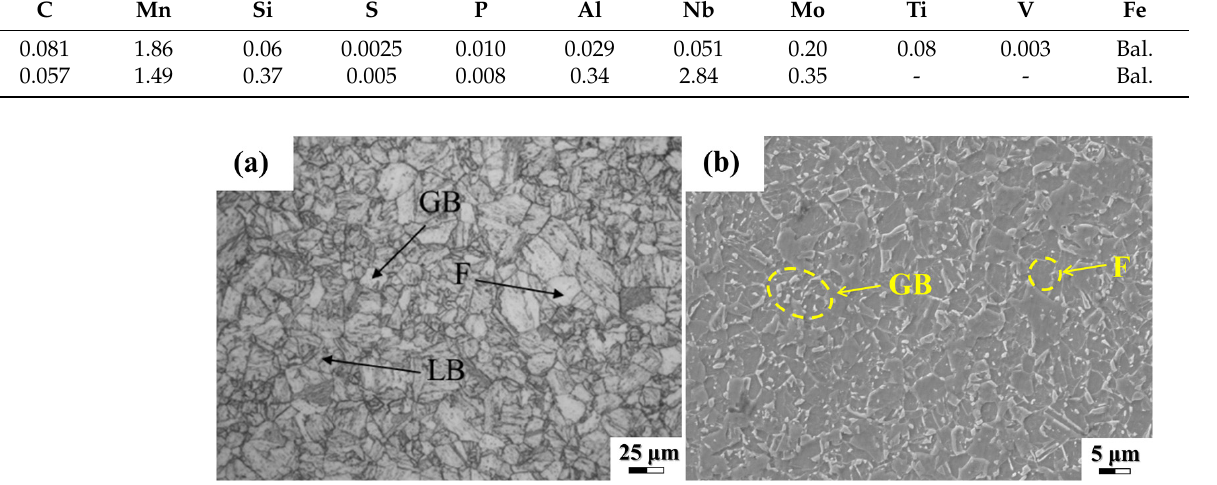
Figure 1. The microstructure of the BM: ( a ) optical microscope (OM) ( b ) scanning electron microscope (SEM). Table 2. Basic mechanical properties of the BM.